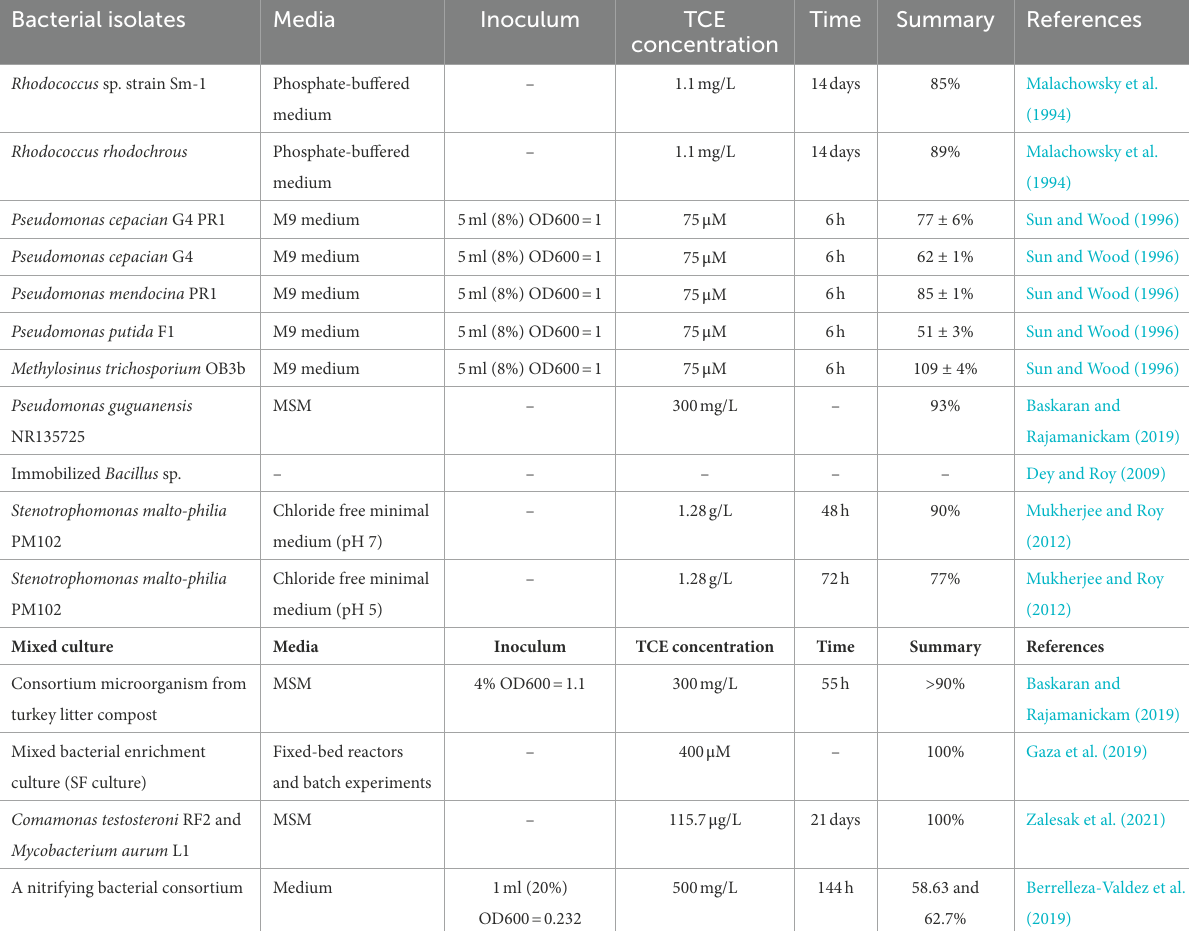
TABLE 6 Aerobic direct oxidation of TCE by bacterial isolates and mixed